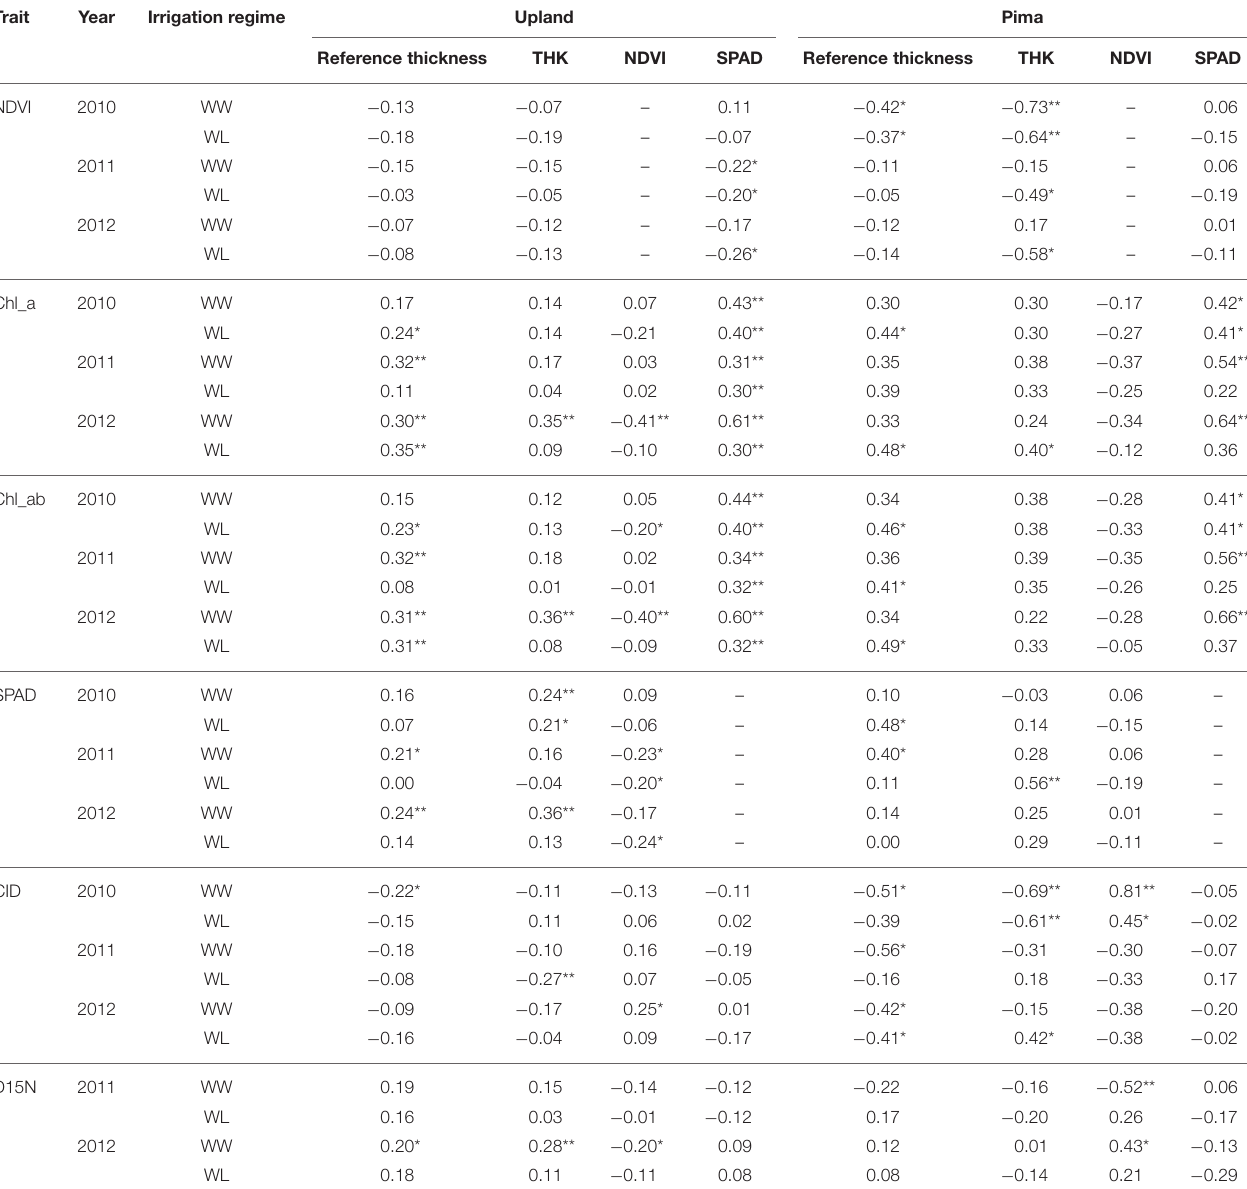
TABLE 4 | Phenotypic correlations (Pearson’s) estimated among various leaf and physiological traits for the upland recombinant inbred line (RIL) and Pima populations tested under two irrigation regimes, water-limited (WL) and well-watered (WW) conditions.